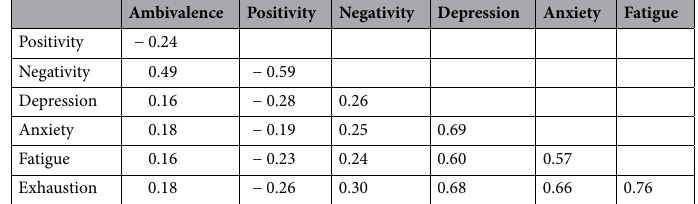
Table 2. Correlation between key